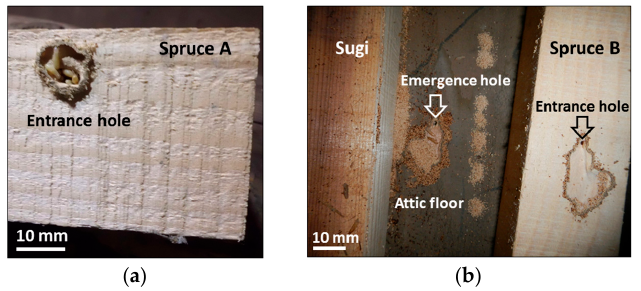
Figure 1. Nest-gallery extension from natal colony to adjacent timber activity by an I. minor colony. ( a ) Entrance hole in Spruce A timber; and ( b ) I. minor colony emerged from the attic floor to attack the adjacent bottom surface of Spruce B and Sugi timbers.